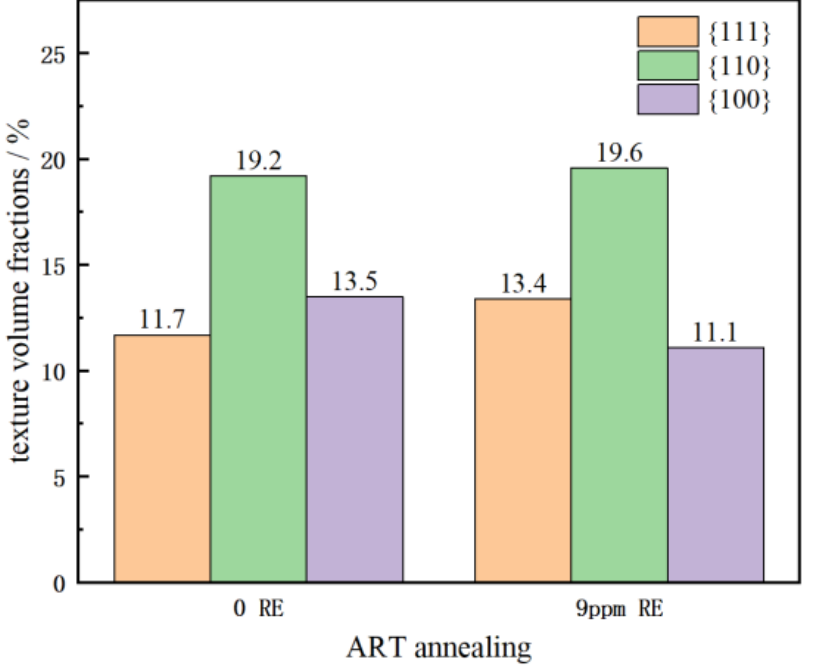
Figure 8. Texture contents of two groups of experimental steels after different annealing processes.